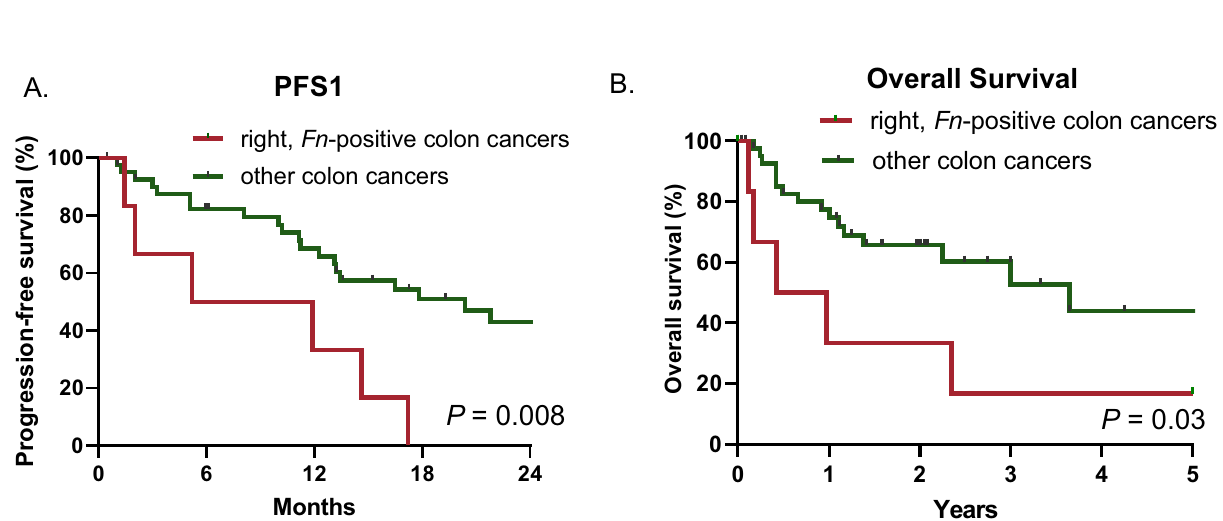
Figure 3. Kaplan–Meier curves of ( A ) progression-free survival (PFS) and ( B ) overall survival (OS) for Fn enriched, right-sided colon versus others in the validation cohort using The Cancer Genome Atlas (TCGA) colon cancer data. Others include (1) Fn enriched, left-sided colon cancer, (2) Fn negative, right-sided colon cancer, and (3) Fn negative, left-sided colon